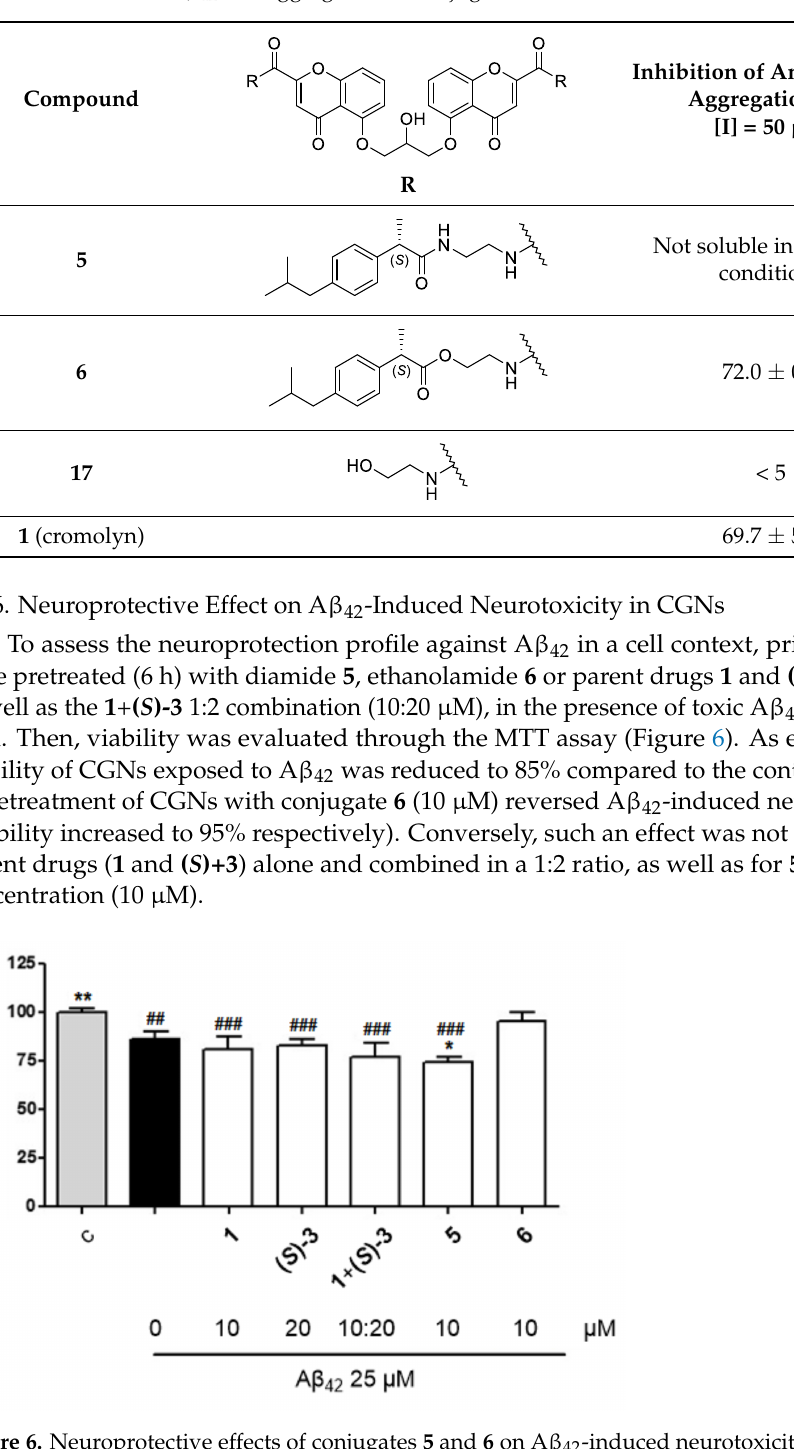
Figure 6. Neuroprotective effects of conjugates 5 and 6 on A β 42 -induced neurotoxicity in cerebellar granule neurons (CGNs). Cells were pretreated (6 h) at 10 µ M concentrations of the tested